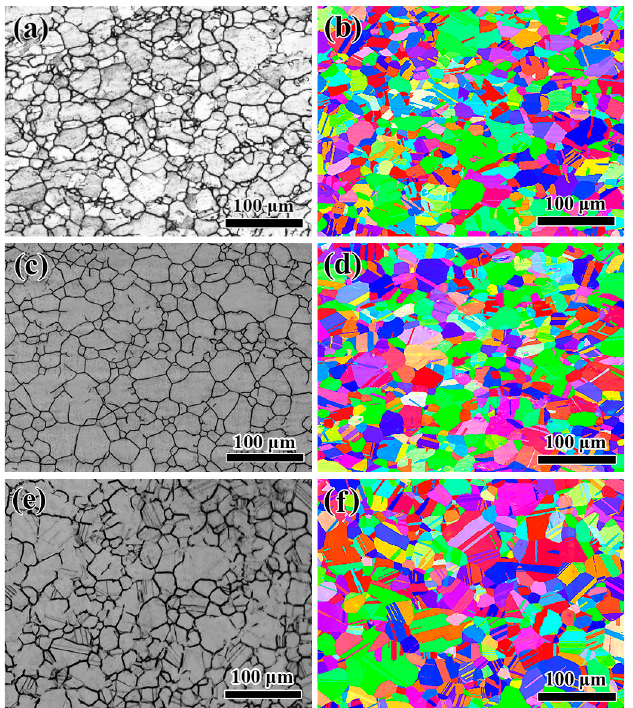
Figure 2. OM images and IPF of the BM samples: ( a , b ) Ni-5at.%Cr; ( c , d ) Ni-20at.%Cr; ( e , f ) Ni-40at.%Cr.